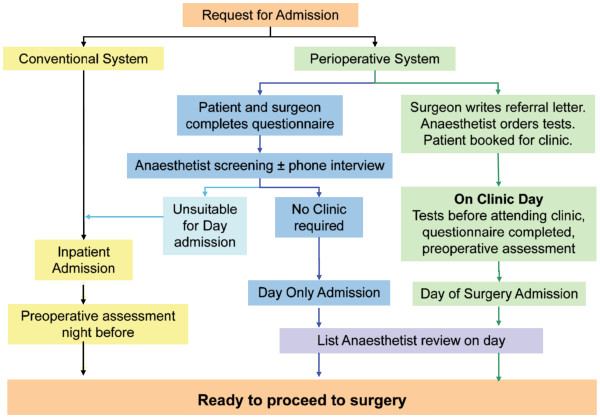
Conventional and Perioperative System preprocedural processes at Prince of Wales Hospital, Hong Kong. There are three types of patient groups: Day only admissions (patients admitted and discharged on the same day after elective surgery), Day of surgery admissions (patients admitted on the day of elective surgery and then stay in hospital for at least one night) and Inpatients (patients admitted before the day of surgery and then discharged on the same day or afterwards following surgery). The Perioperative System was operational in 2006 but a dedicated pre-anesthetic clinic space was not available until July 2008.